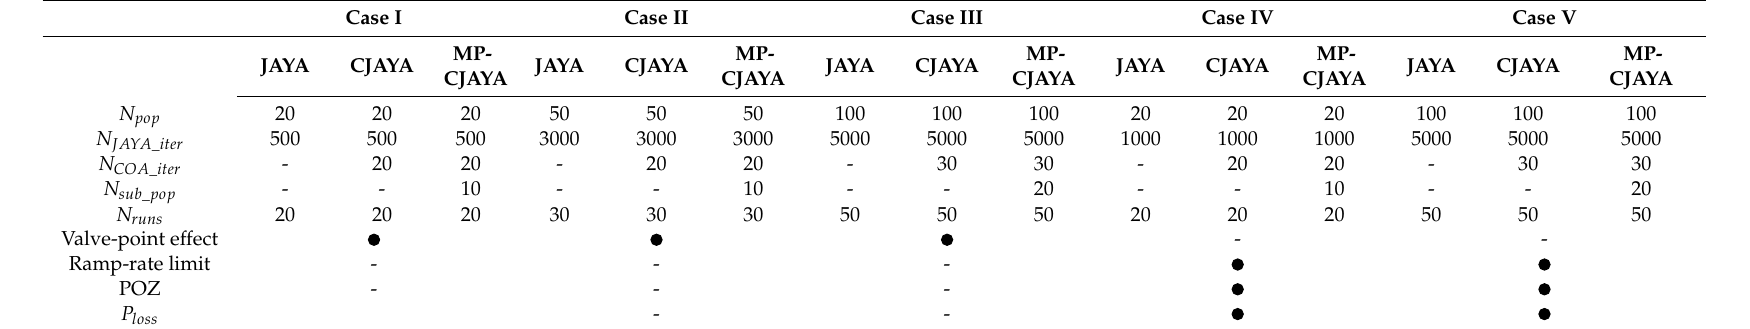
Table 1. Parameters and constraint conditions of the ELD cases.